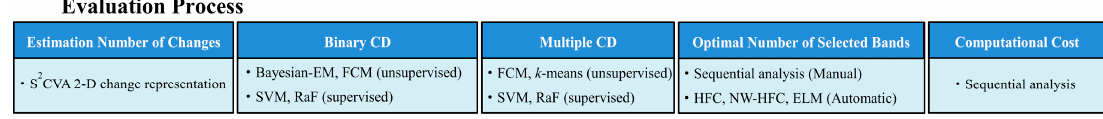
Figure 3. Processes for evaluating the CD performance.